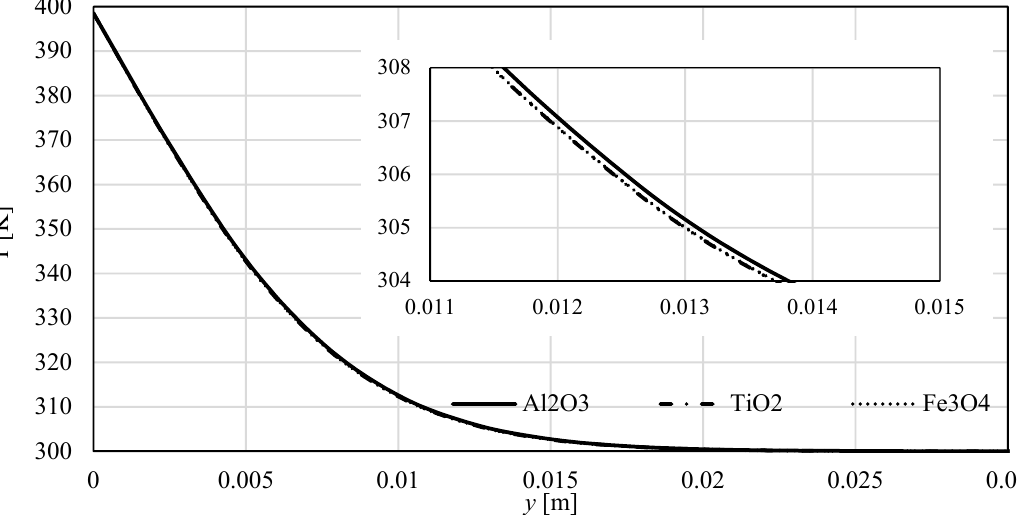
Figure 7. Temperatures profiles perpendicular to the sheet for all three nanofluids; 𝜙 = 0.02 .